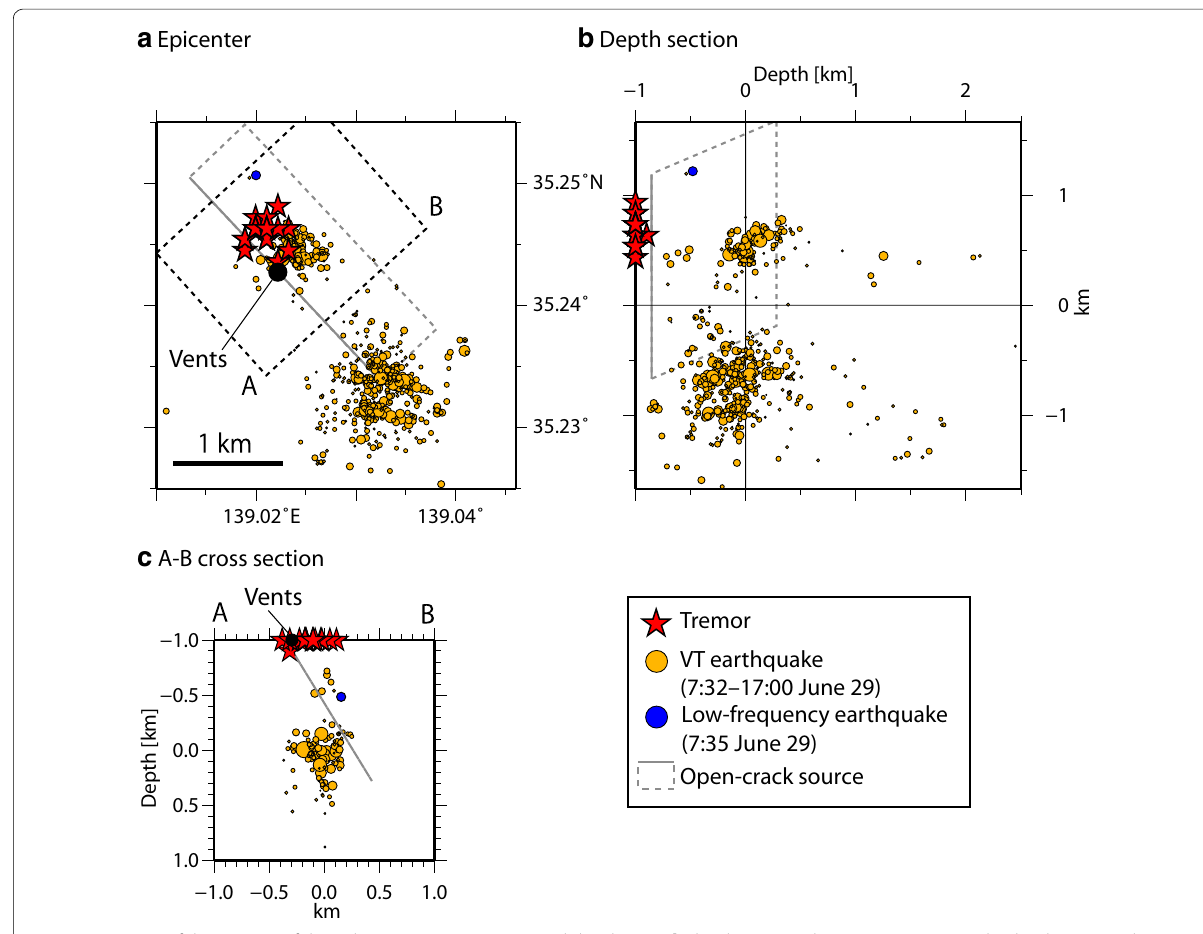
Fig. 9 Locations of the sources of the volcanic tremors. a Epicentral distribution, b depth section along E–W section, and c depth section along A–B section. Red stars indicate the locations of the sources of the tremors, obtained using the envelope correlation method. Orange circles show the hypocenters of VT earthquakes that occurred from 07:32 to 17:00 on June 29, 2015. Blue circles indicate the hypocenters of low-frequency earthquakes. Black circles and gray quadrilaterals represent the locations of vents and the open-crack sources,